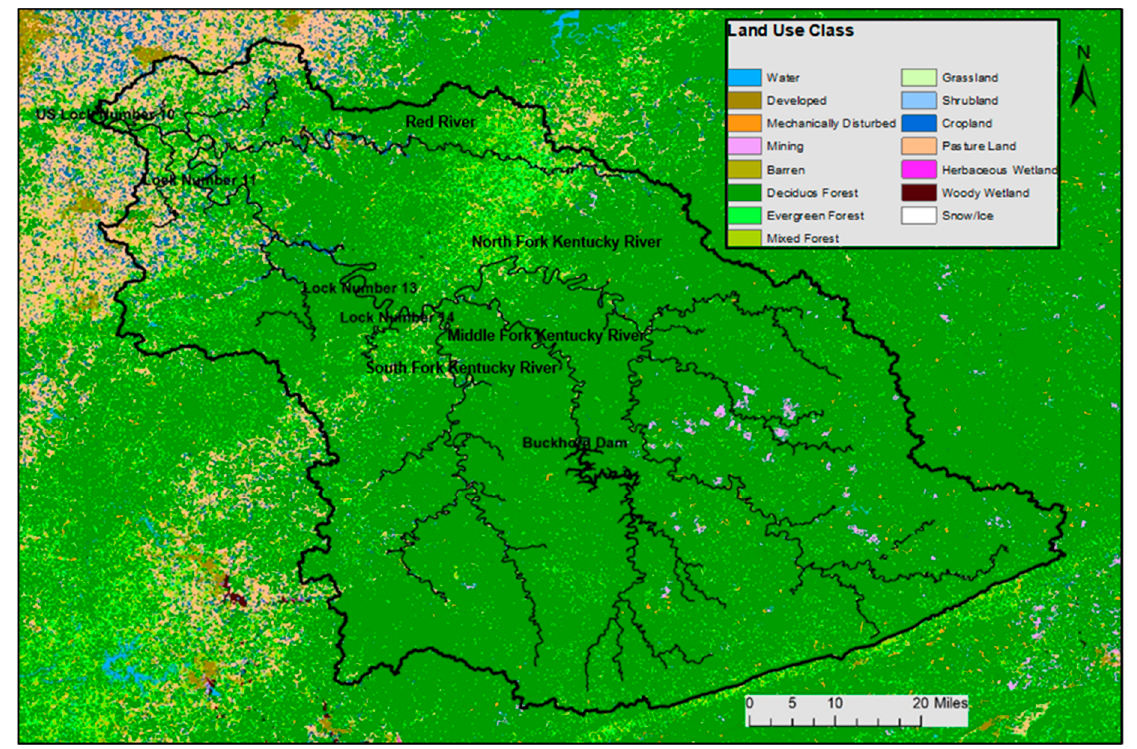
Figure 4. Land use classification of the Upper Kentucky River Basin.